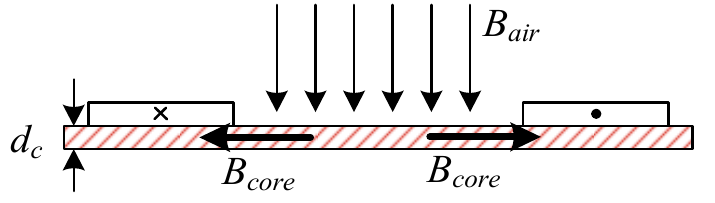
Figure 5. The magnetic flux density of the magnetic core. The magnetic flux density passing through the magnetic core can be calculated